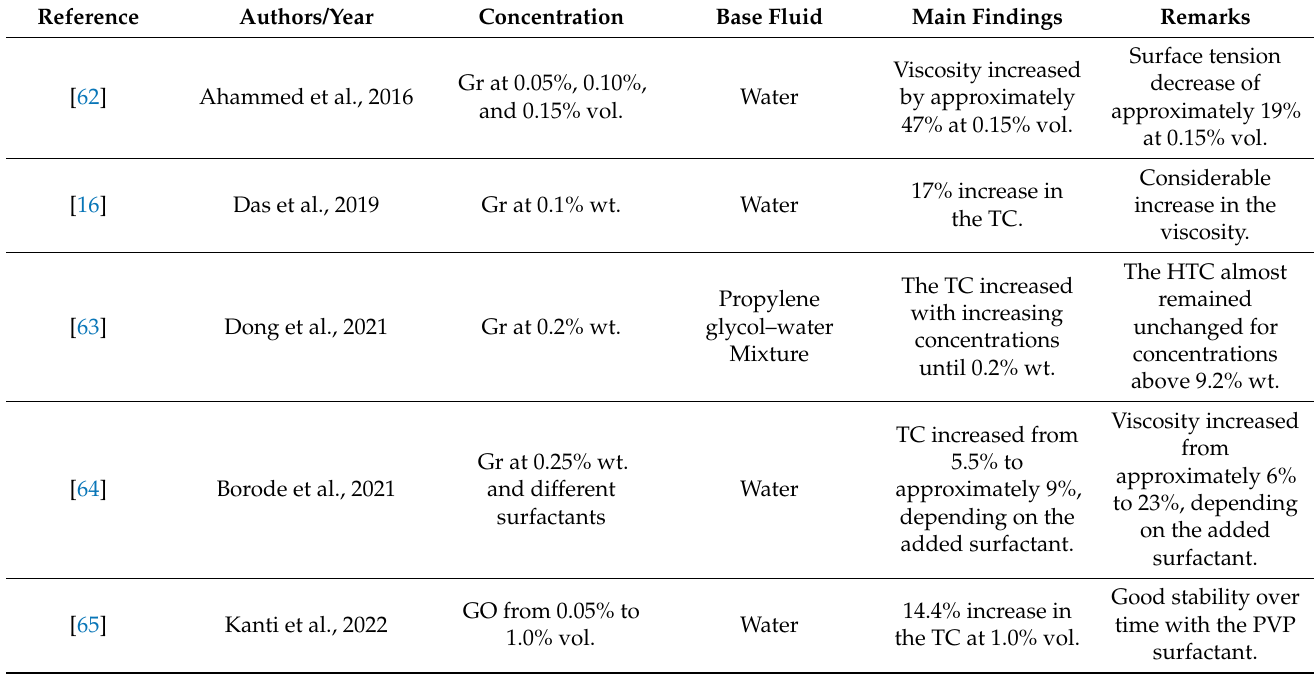
Table 2. Recent works on Gr, GO, and hybrid 2D